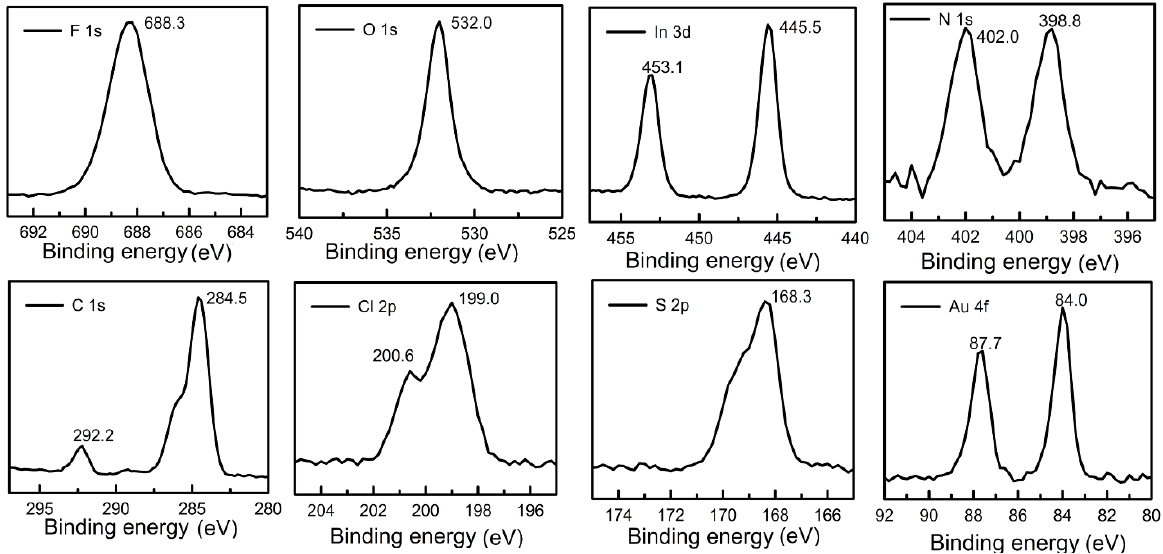
Figure 5. XPS detailed spectra of 0.1 mol/L InCl 3 in [Py 1,4 ]TFSI in the cell setup.